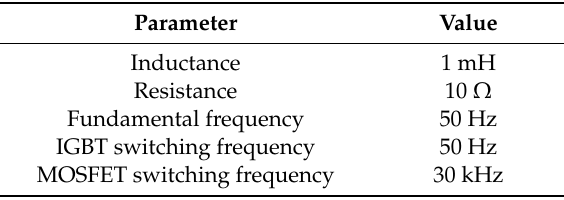
Table 3. Main simulation and experimental